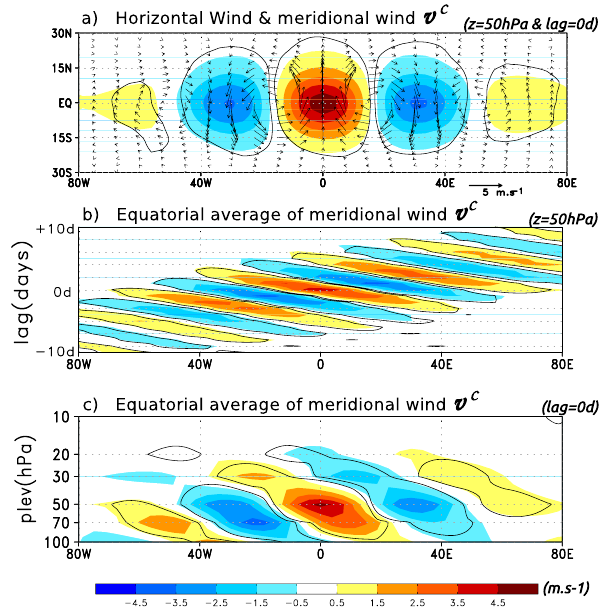
Fig. 7. RGW composites from ERAI: (a) meridional wind v C (shad- ing) and horizontal wind (u C ,v C ) (arrows) at z p = 50hPa and l = 0 day lag. (b) Hovmöller diagram of the meridional wind v C at z p = 50hPa. (c) Longitude–altitude cross section of the meridional wind v C averaged over the equatorial band. Shaded areas of merid- ional wind values are in red (blue) for positive (negative) (ms − 1 ). The black lines delimit the 99% significant regions according to a Student t test for the meridional